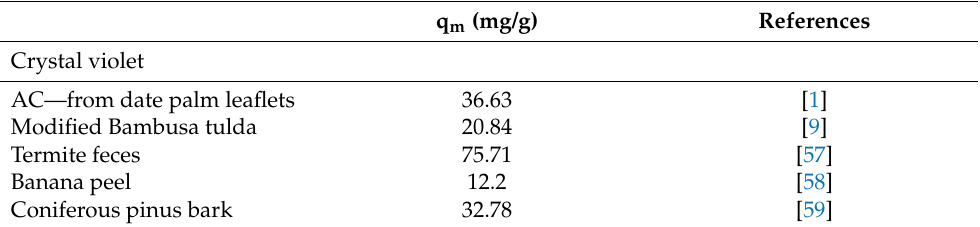
Table 6. Comparison of maximum biosorption capacity (qm mg g − 1 ) for CV and MG of some biosorbents in the